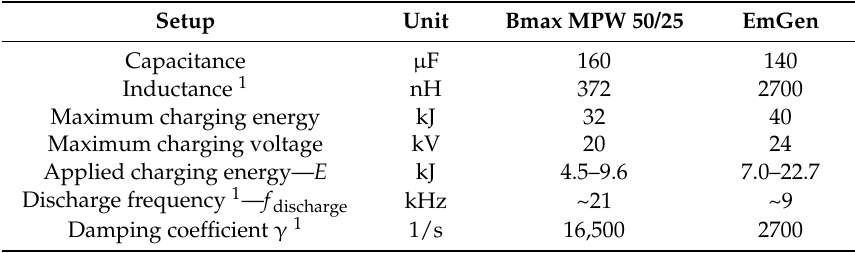
Table 3. Characteristics of the resonant circuits and the deployed pulse generators.